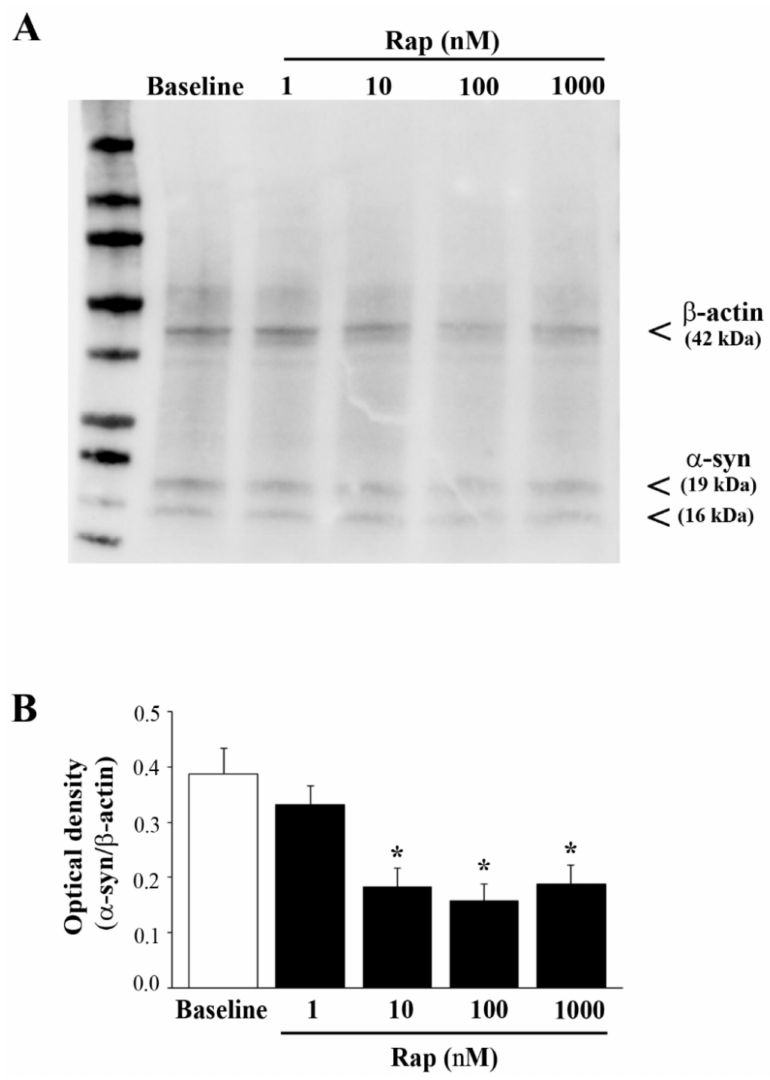
Figure 8. Rapamycin reduced α -syn assessed by immunoblotting. ( A ) Representative immunoblot- ting for α -syn and the housekeeping β -actin in baseline conditions (baseline) and in rapamycin-treated U87MG cells. ( B ) The ratio between the optical densities of α -syn and β -actin is reported in the graph. Data are given as the mean ± SEM of the optical density of n = 5 values for each experimental group, measured in N = 5 independent experiments. The original figure of Figure 8A can be found in Supplementary Figure S4. * p < 0.05 compared with